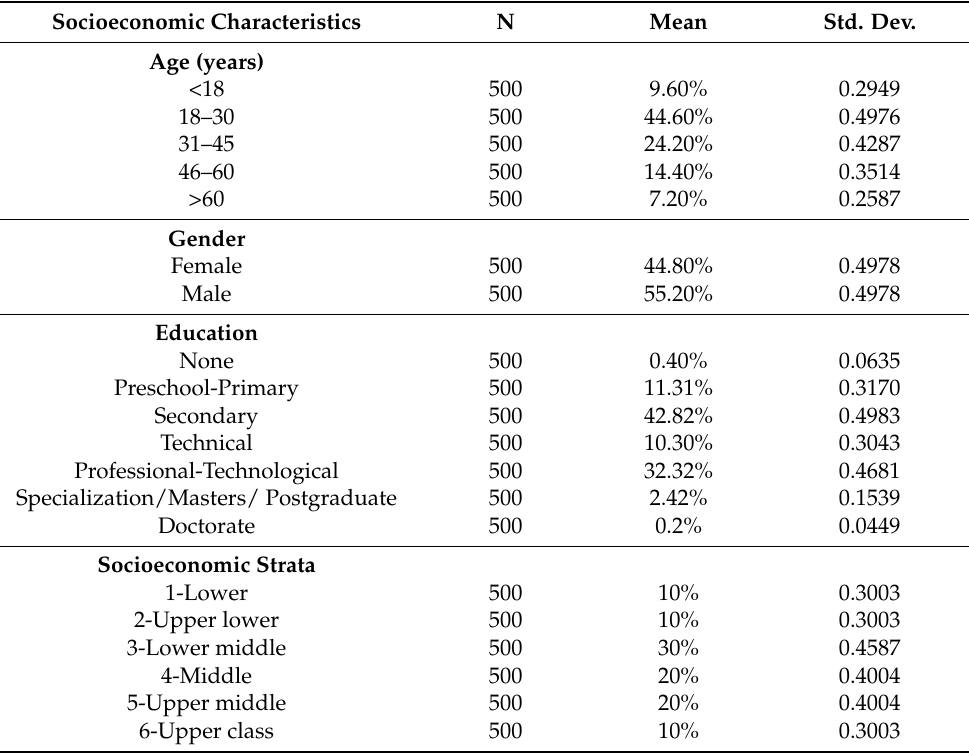
Table 2. Socioeconomic characteristics of respondents in the El Salitre sub-watershed in Bogota,